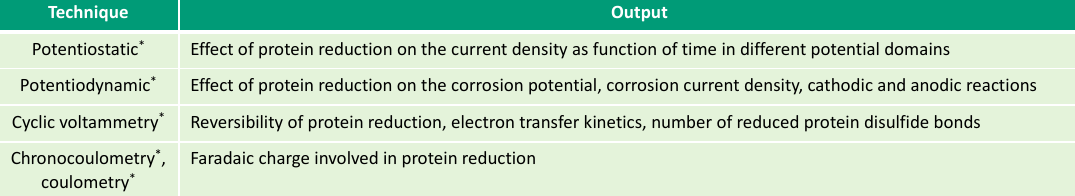
Figure 3. Electrochemical techniques used for investigation of albumin reduction (* in-situ techniques).